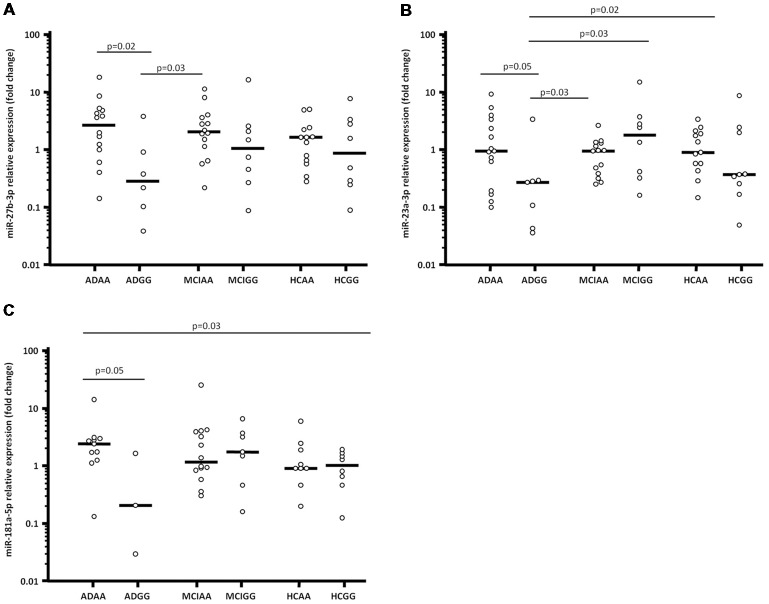
miR-27b-3p (A), miR-23a-3p (B) and miR-181a-5p (C) expression fold (Log10 transformed) in serum of Alzheimer’s disease (AD) patients, mild cognitive impairment (MCI) individuals and healthy controls (HCs) splitted forsynaptosomal-associated protein of 25 kDa (SNAP-25) rs363050 genotype. ADAA, AA homozygous AD patients; ADGG, GG homozygous AD patients; MCIAA, AA homozygous MCI individuals; MCIGG, GG homozygous MCI individuals; HCAA, AA homozygous HCs; HCGG, GG homozygous HCs.